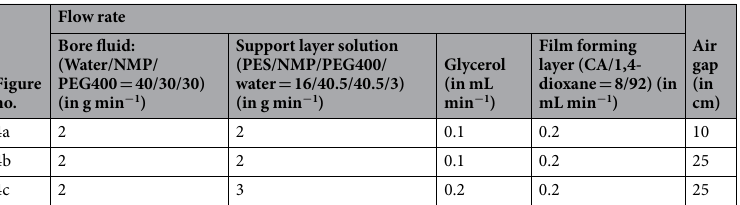
Table 3. Spinning parameters applied for the experiments of Fig.